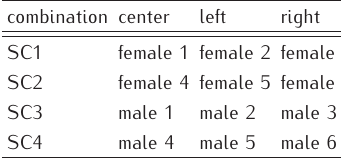
Table 3. Sound Source Combination.